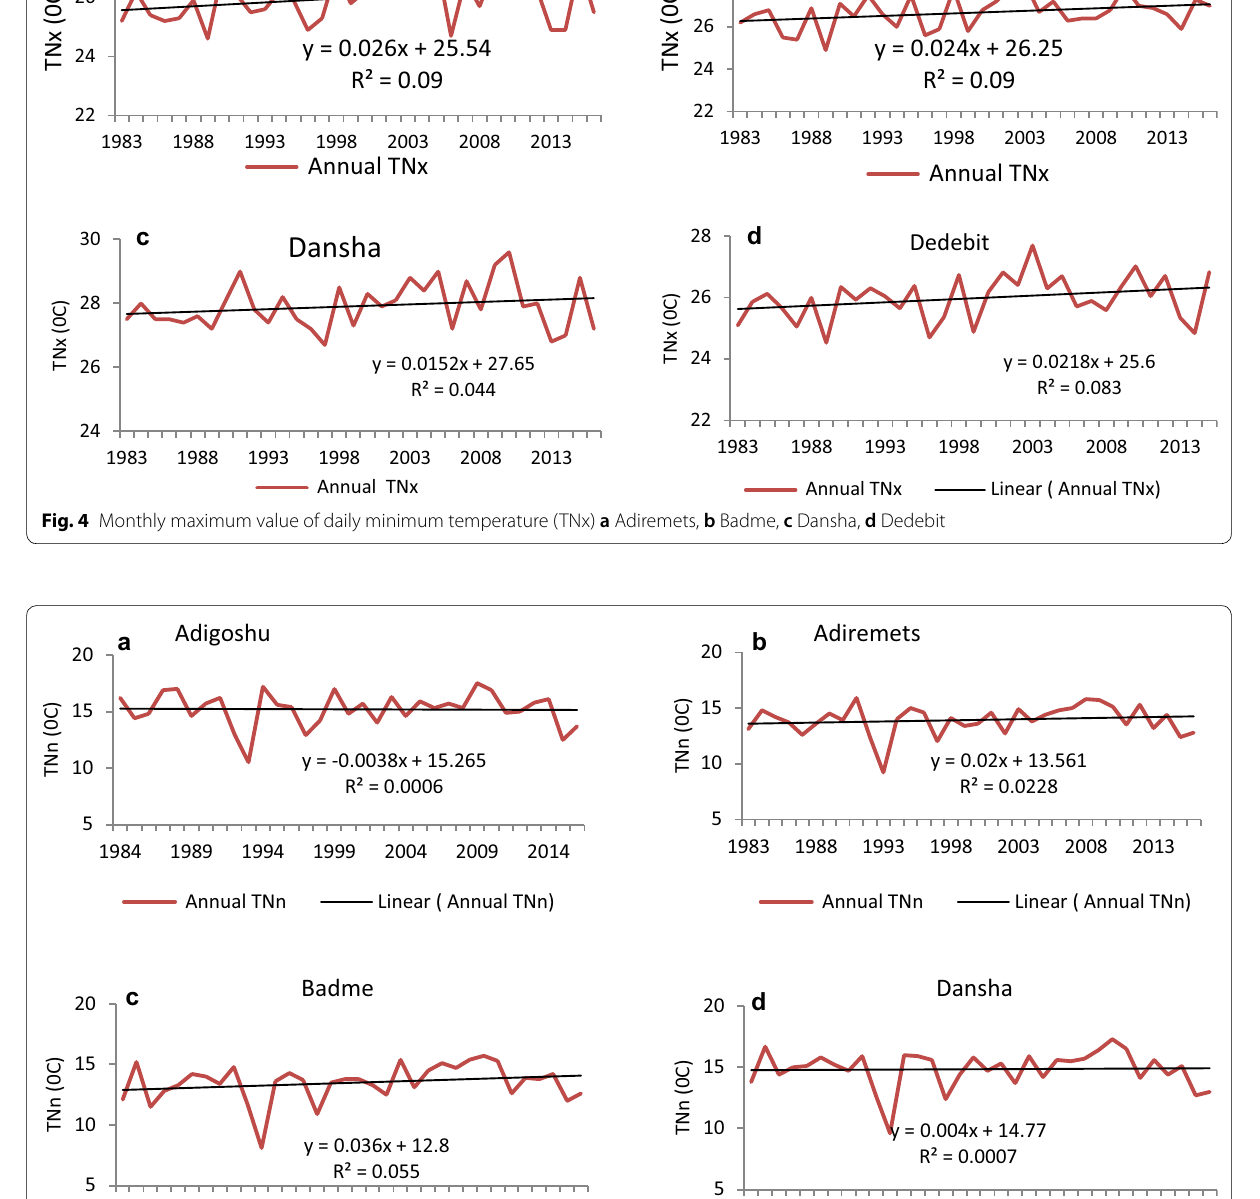
Fig. 5 Monthly minimum value of daily minimum temperature at (TNn), a Adigoshu, b Adiremets, c Badme, d Dansha, e Humera and f